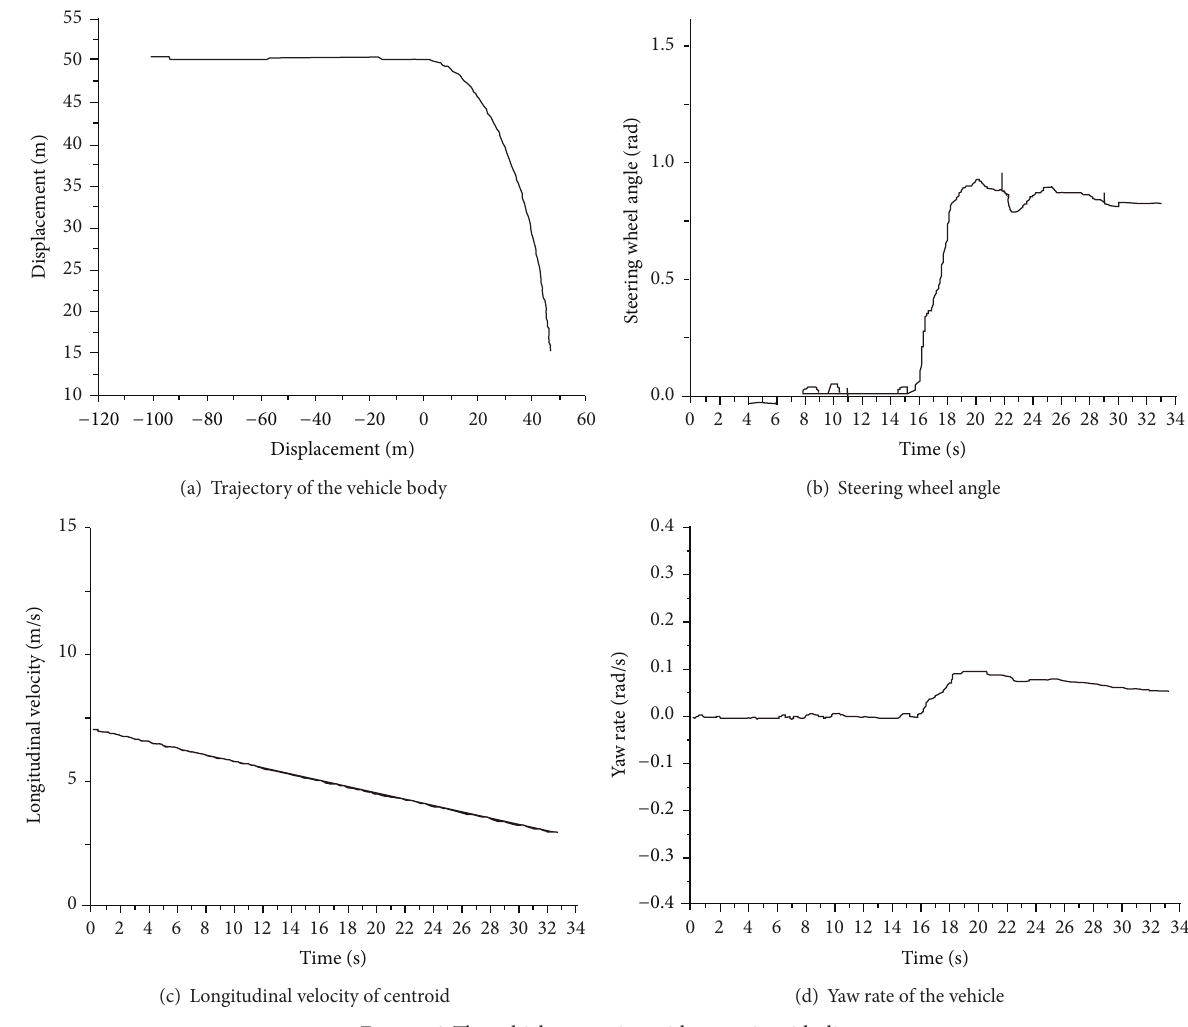
Figure 6: The vehicle cornering with excessive